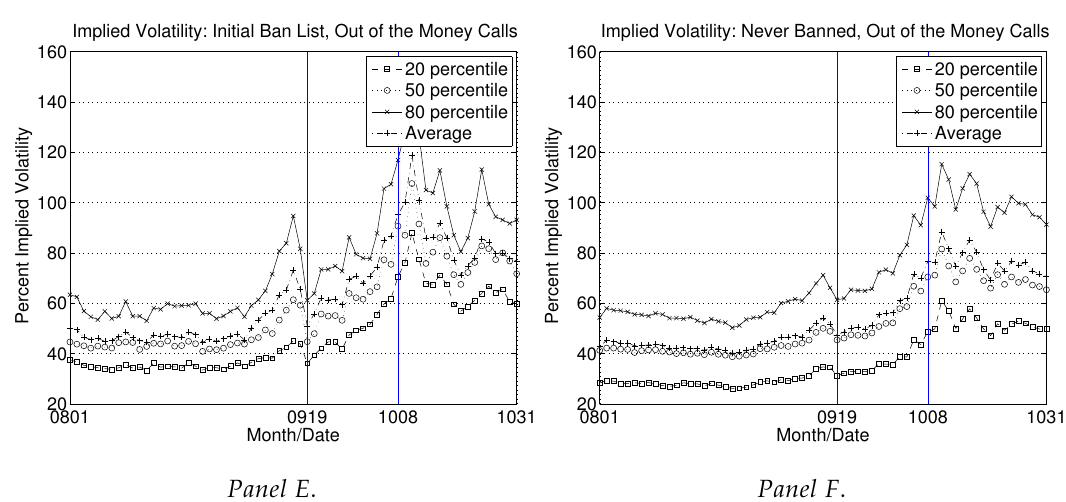
Figure 5. Time series of cross sectional options summary statistics: Out of the money call options of Initial Ban List and Never Banned Stocks during the ban and non-ban periods: ( A , C , E ) results for the three variables for Initial Ban List Stocks; and ( B , D , F ) results for the three variables for Never Banned